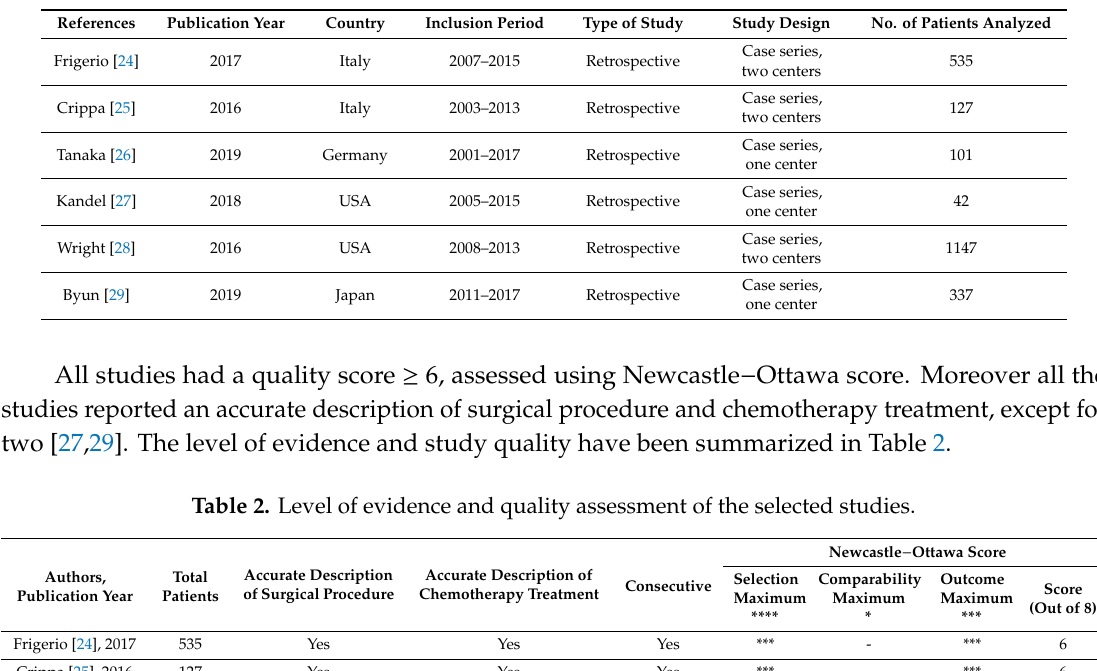
Table 1. Characteristics of the studies.